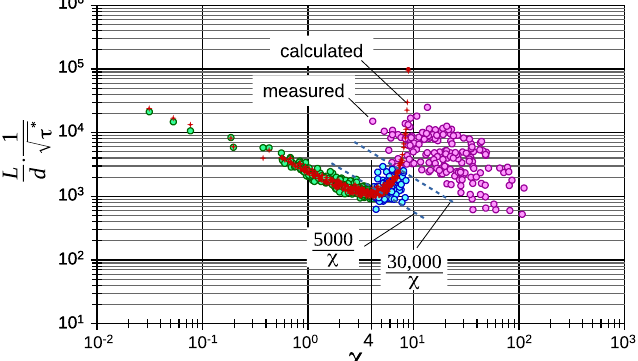
Figure 10. Comparison of the measured data and Equation (35) (red). For data source, see Section